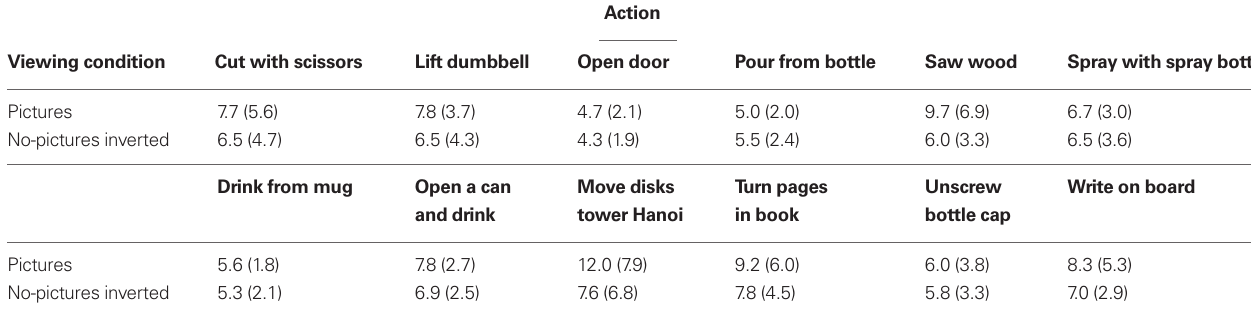
Table 3 | Mean number of segmentation marks as a function of viewing condition and action (SDs in